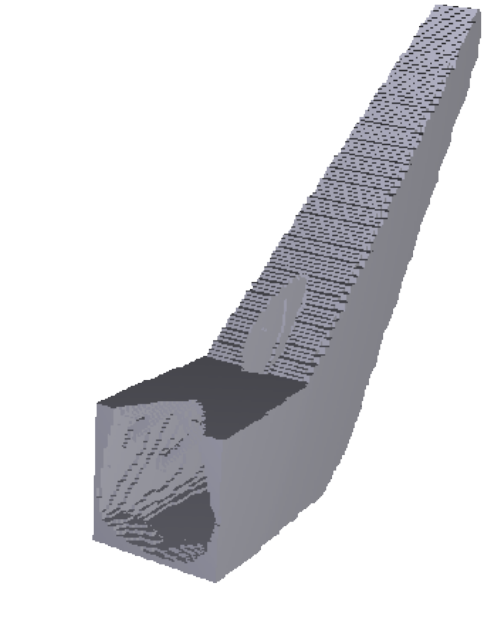
Figure 9. TO result considering the Z axis as the printing